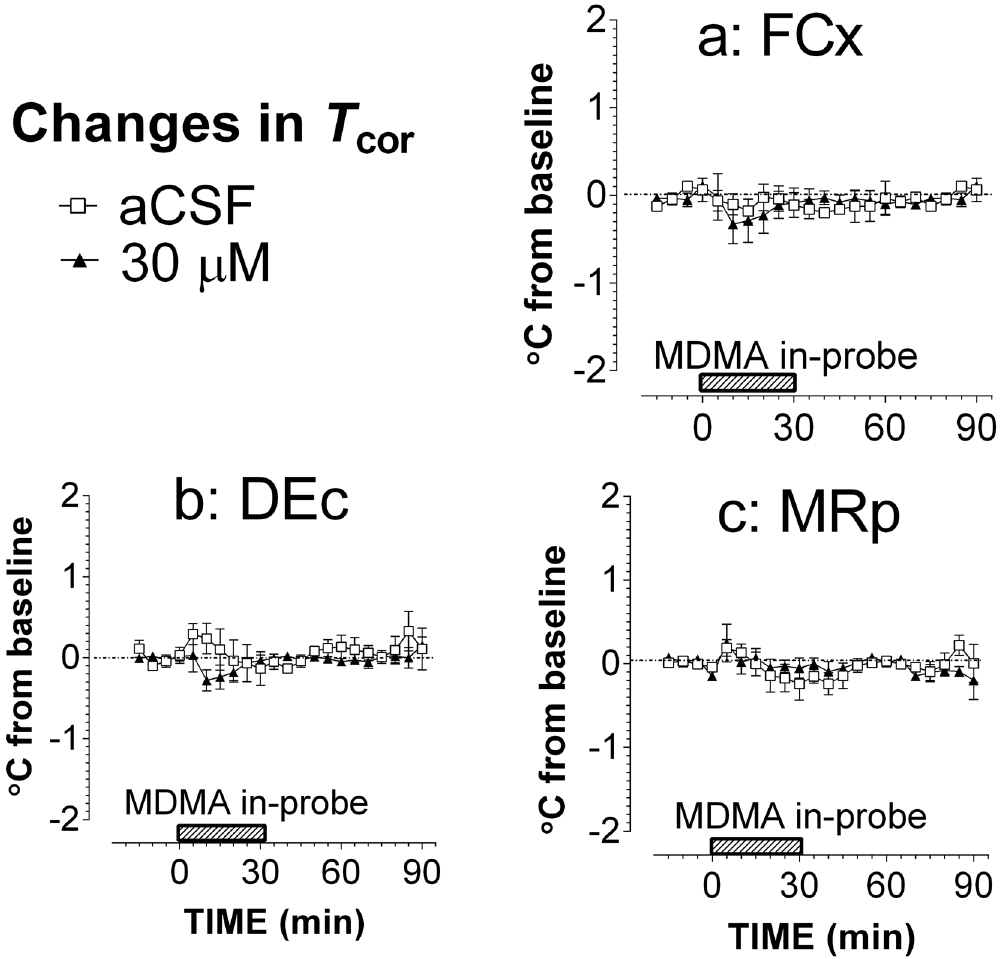
Fig 3. Relationship between intracranial administration of MDMA and occurrence of serotonin syndrome in male Sprague-Dawley rats. The route of intracranial administration was reverse microdialysis. Serotonin syndrome was determined by measuring changes in body-core temperature ( T cor ). Hatched horizontal bars indicate the time period of aCSF ( □ ), or 30 μ M MDMA infusion ( ▲ ) in the delivery site. Data are expressed as mean ± s.e.m. a, Bilateral reverse microdialysis in the FCx had no effect on T cor (n = 5 rats/group). b, Bilateral reverse microdialysis in the DEc had no effect on T cor (n = 5 – 6 rats/group). c, Singular reverse microdialysis in the MRp had no effect on – 6 T cor (n = 5